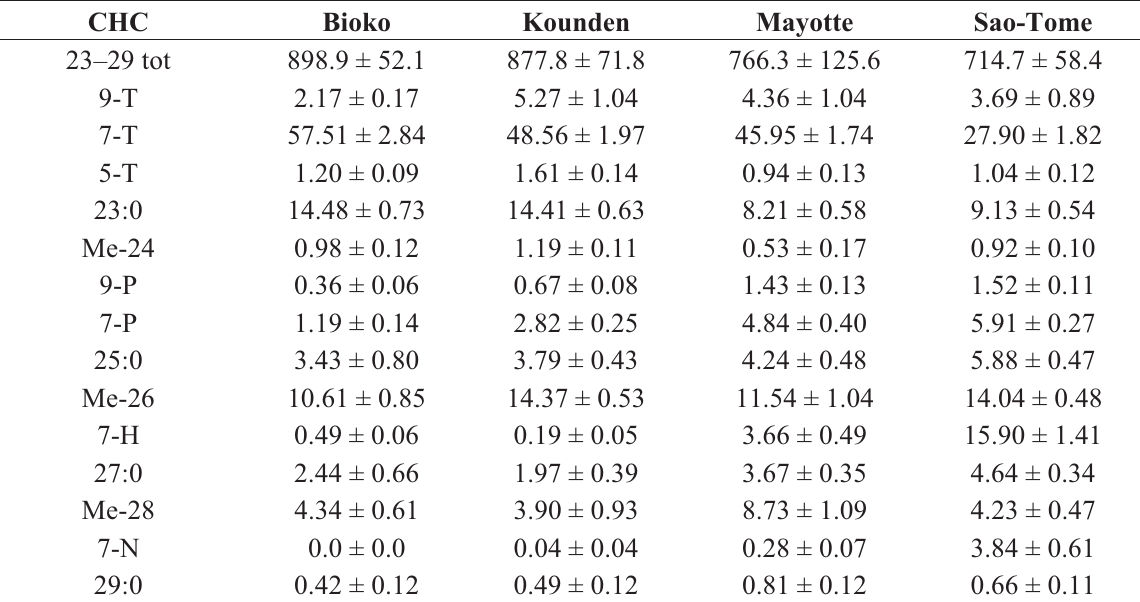
Table 1. Male CHC profiles of four strains of D. yakuba .